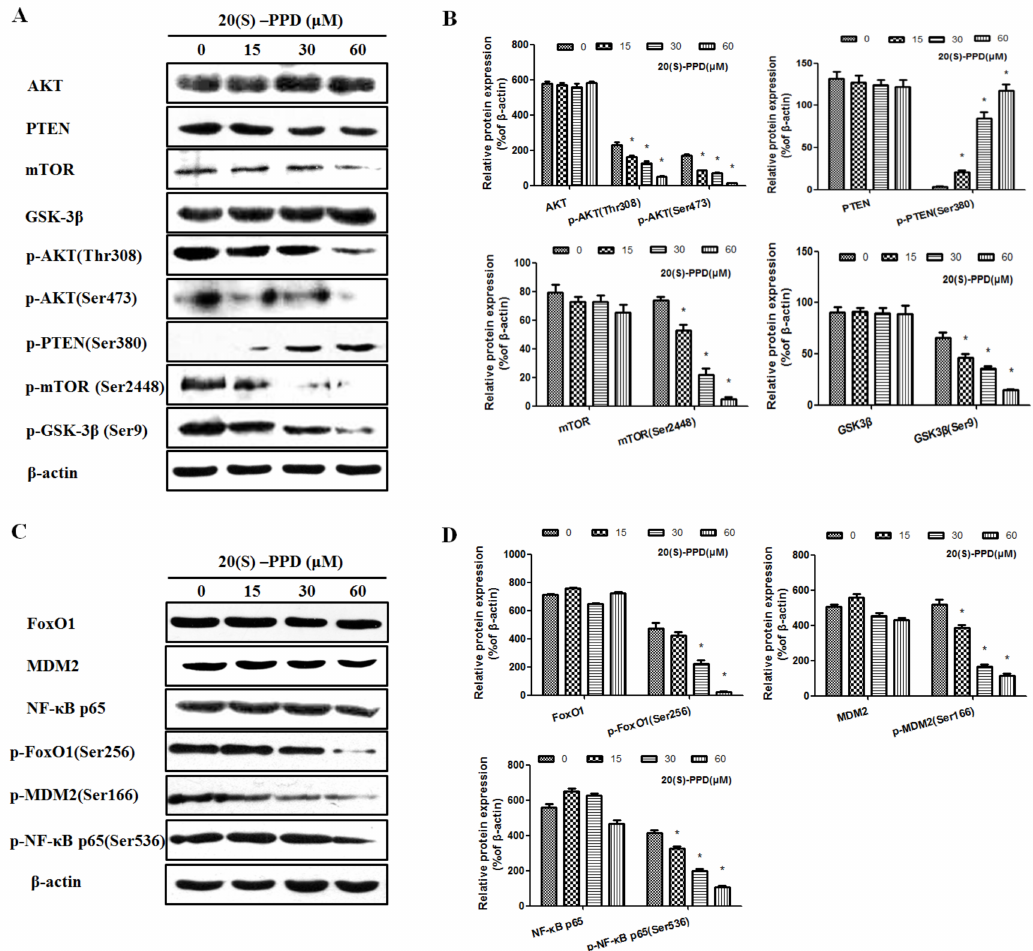
Figure 2. Effects of 20(S)-PPD on the PI3K/AKT/mTOR pathway and the downstream protein expression in MCF-7